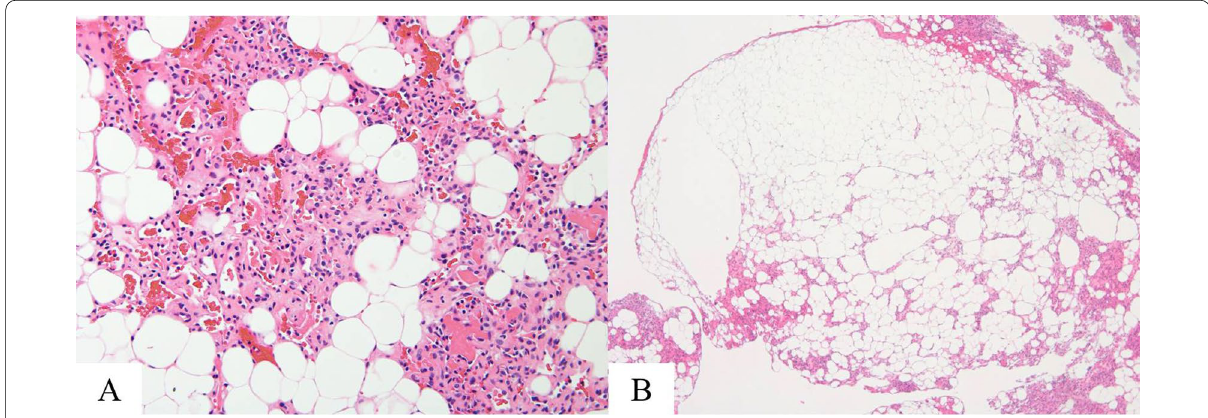
Fig. 4 Histopathological findings. Histopathological examination of the tumor showed mature adipose tissue and capillary hyperplasia containing fibrin thrombi ( A H&E, 200). The tumor was well-defined and encapsulated ( B H&E, ×